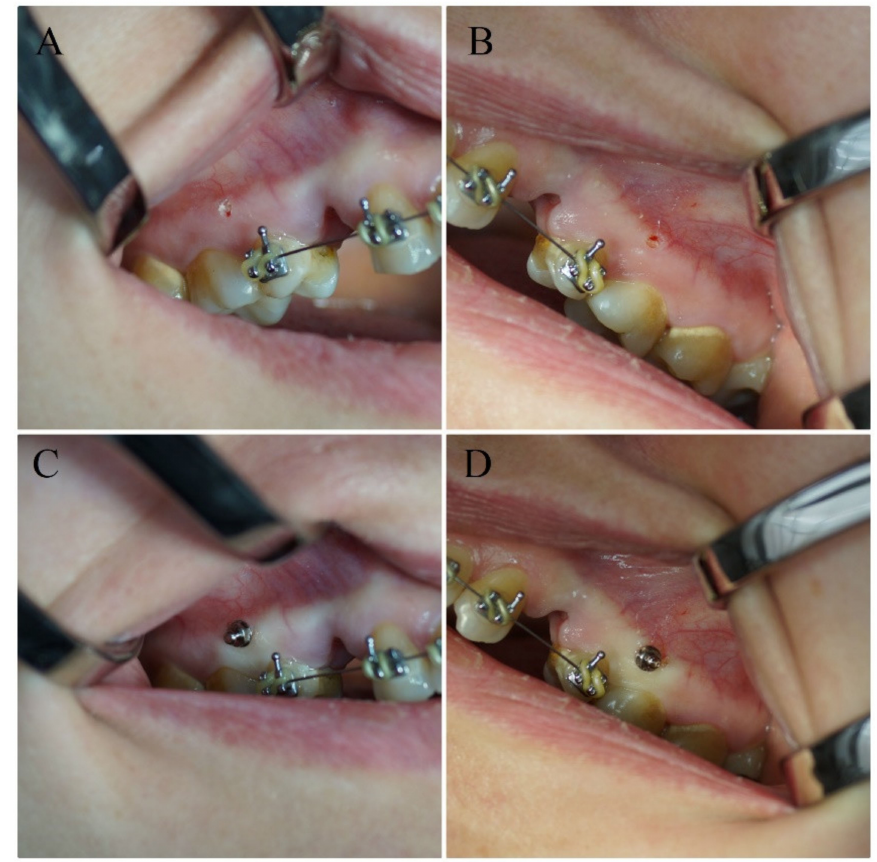
Figure 2. Soft tissue removal and implantation on the right ( A , C ) and left ( B , D ) side of the maxillary